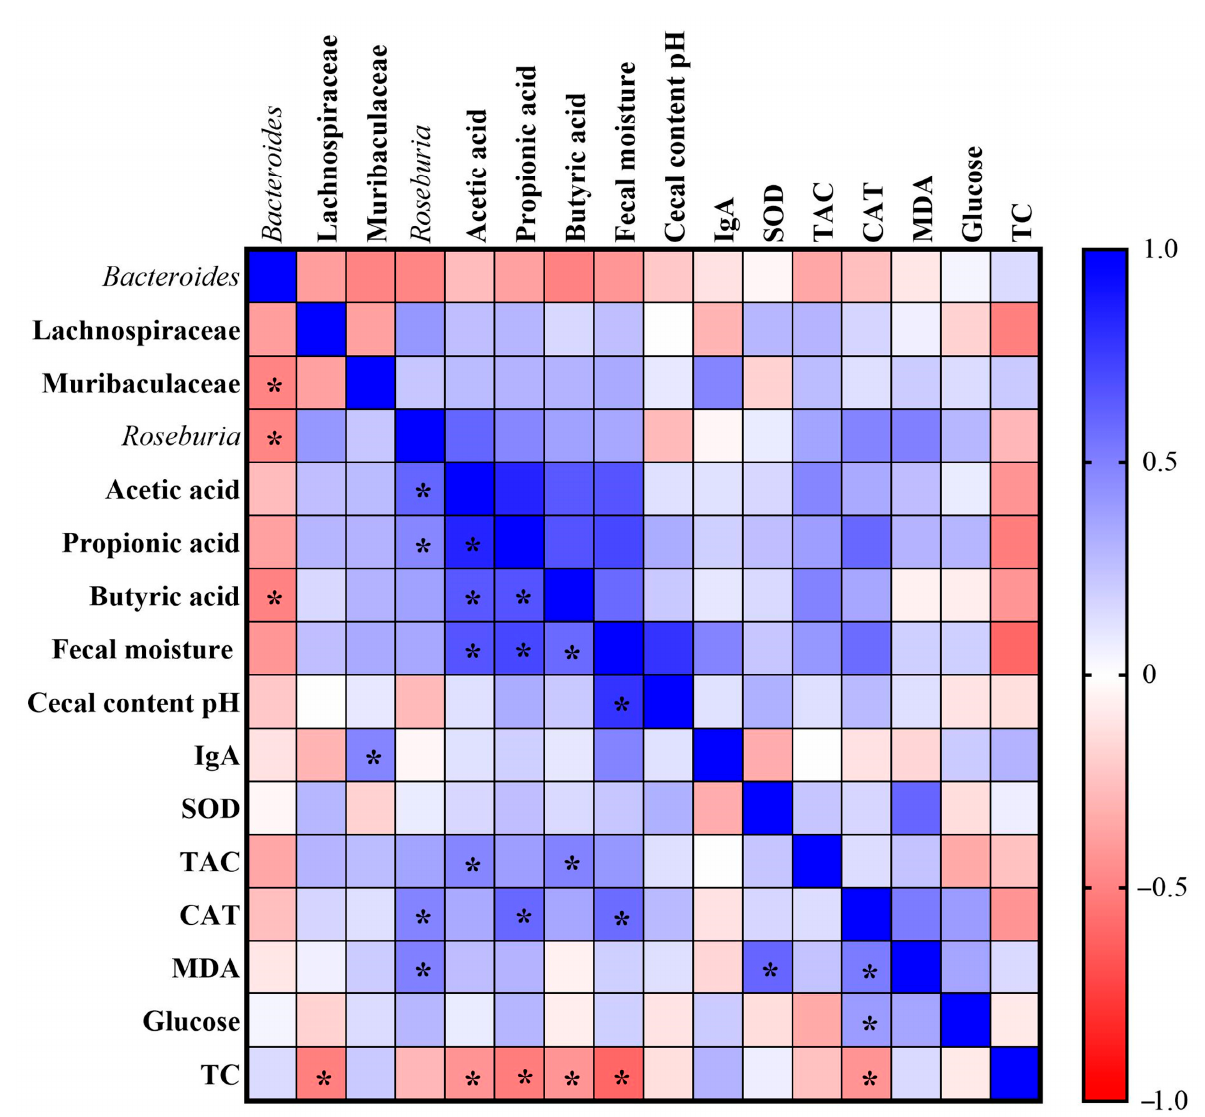
Figure 7. Heatmap of Pearson correlation analysis. IgA: immunoglobulin; SOD: superoxide dismu- tase; TAC: total antioxidant capacity of plasma; CAT: catalase; MDA: malondialdehyde; TC: total cholesterol. * Indicates statistically significant difference.